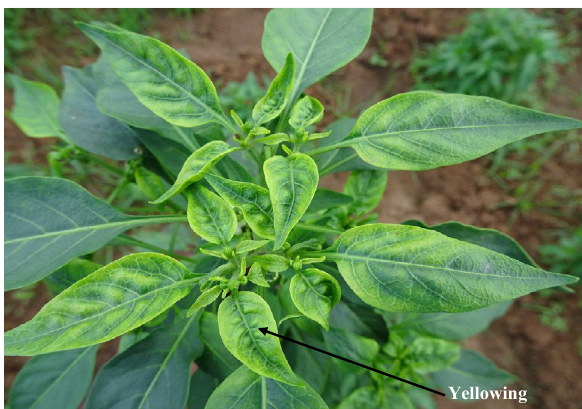
Figure 1a: Above ground symptom of root-knot nematode (Nedunkeny, Mullaithevu)